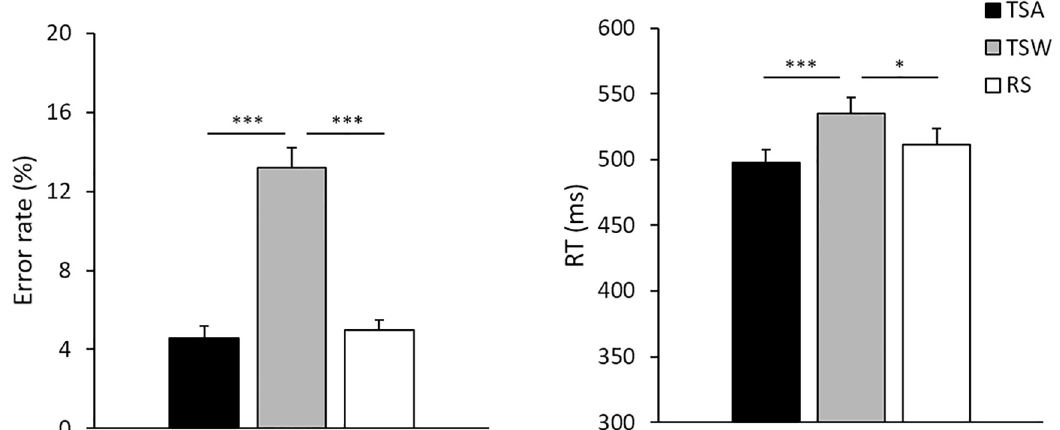
Fig 2. Behavioral results of reaction time (RT) and error rate for TSA, TSW, and RS conditions. Note: � p < .05, �� p < .01, ��� p < .001.